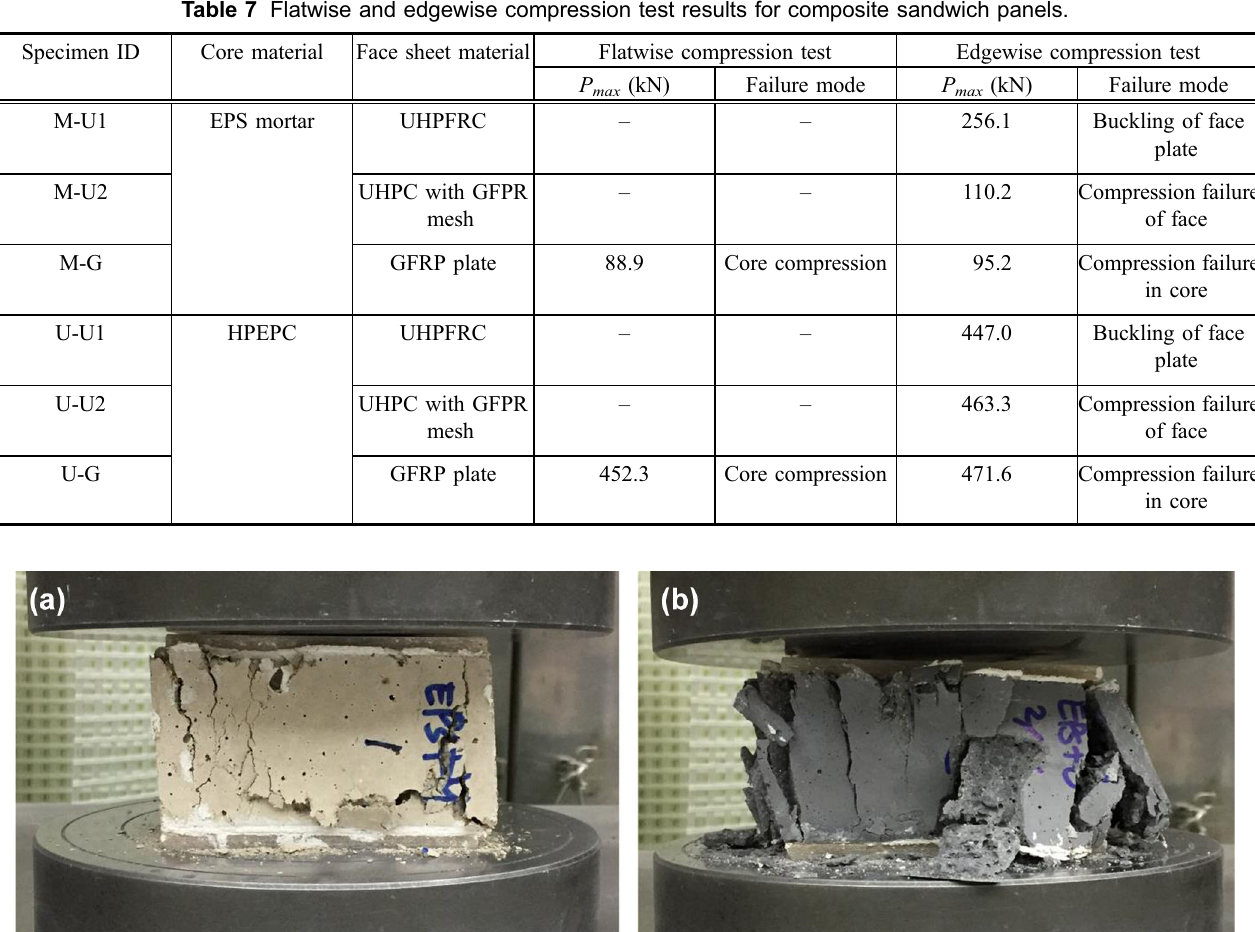
Fig. 7 Flatwise compression test results; a M-G specimen and b U-G specimen.